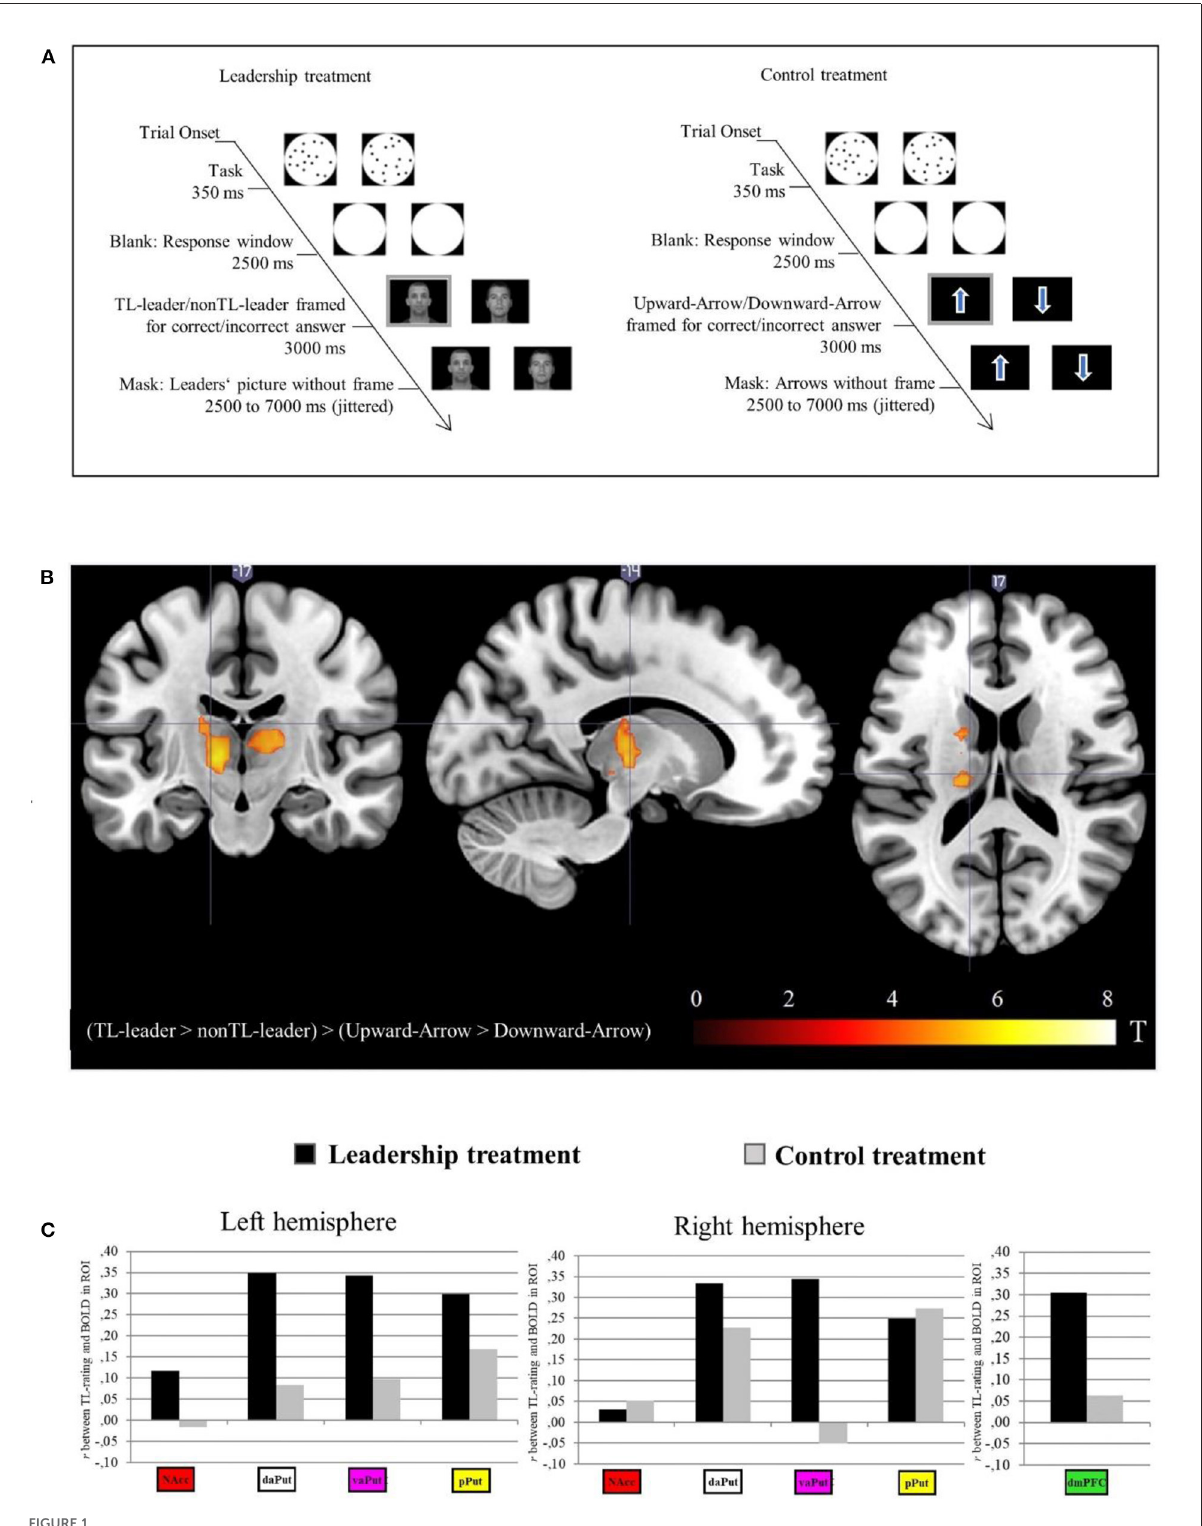
FIGURE1 Paradigm (A) , whole-brain analysis (B) and correlation between BOLD-signal and behavioral ratings on transformational leadership (C) . NAcc, Nucleus accumbens; daPut, dorsal anterior putamen; vCaud, ventral caudate; vaPut, ventral anterior putamen; dCaud; dorsal caudate; pPut, posterior putamen; dmPFC, dorsomedial prefrontal cortex. Facial images reproduced with permission from the Max Planck Institute for Human Development, Center for Lifespan Psychology, Berlin, Germany, available at